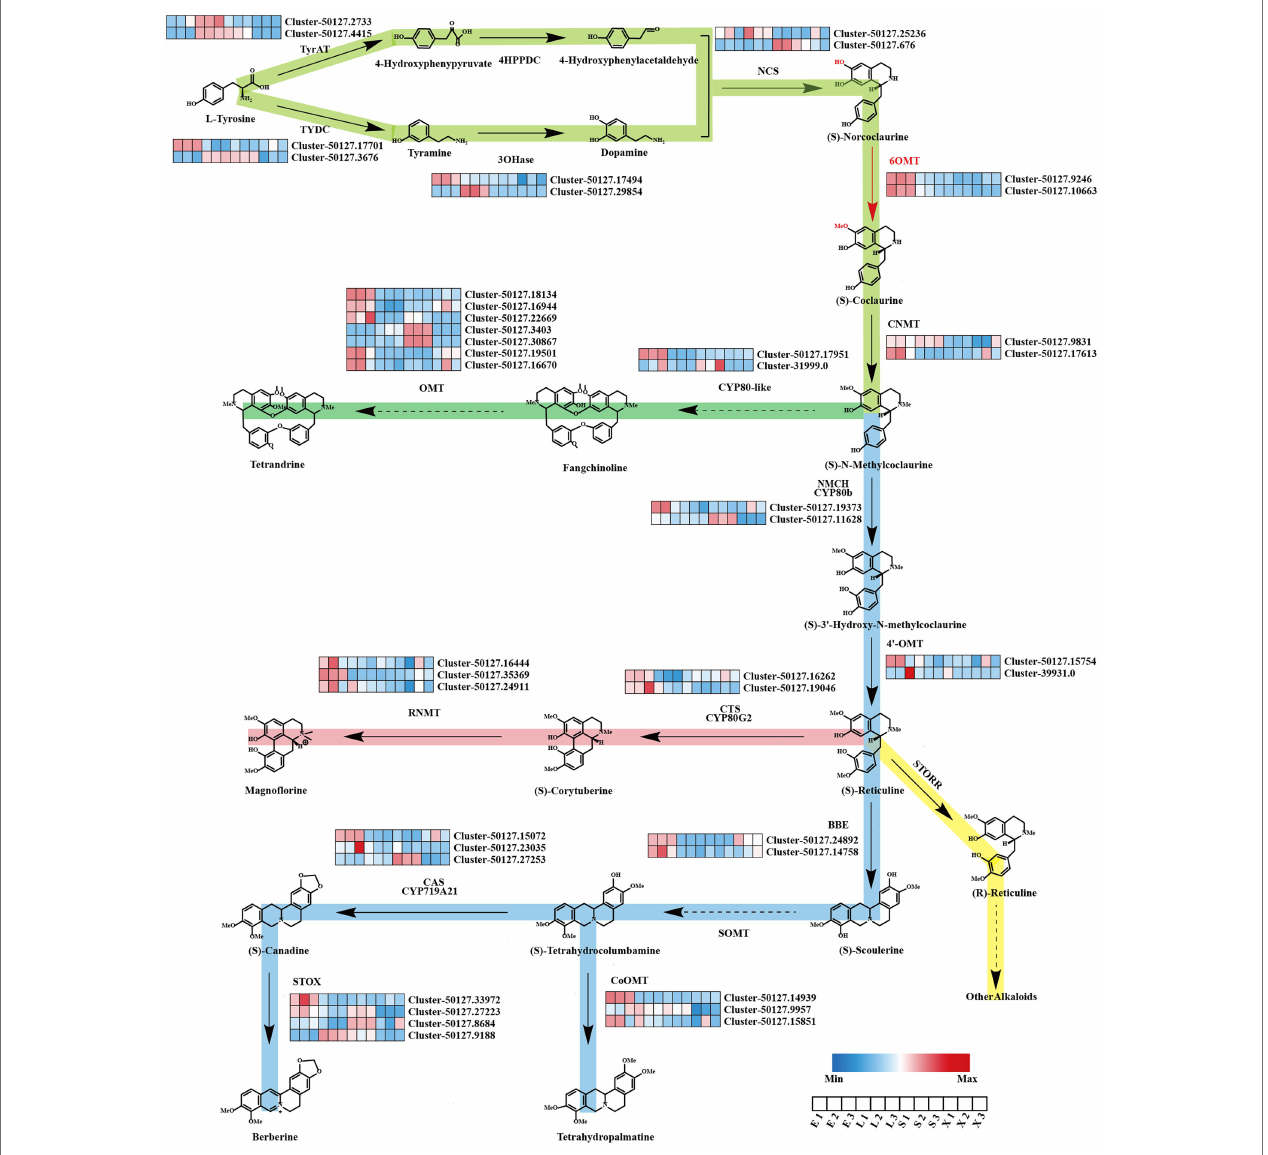
FIGURE 3 | Putative biosynthesis pathways of BIAs and expression patterns of genes related to BIAs in Stephania tetrandra . E, epidermis; L, leaf; S, stem; X,